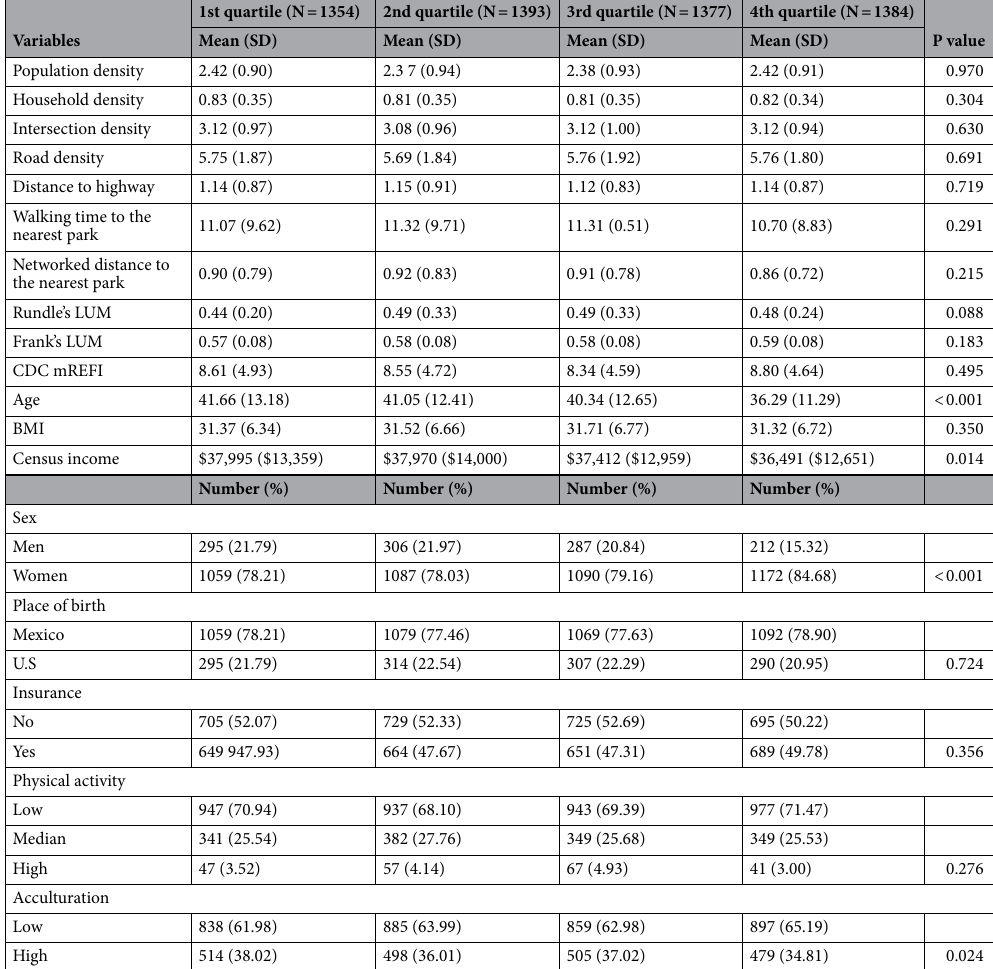
Table 1. Description of built environment variables covariates of in quartile levels of telomere